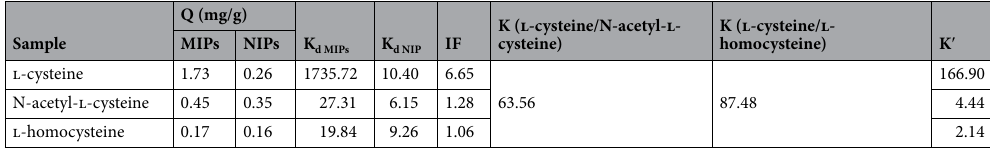
Table 1. Adsorbed mass (Q), distribution coefficients (K d ), imprinting factor (IF), selectivity factors (K), and relative selectivity coefficient (K ′ ).